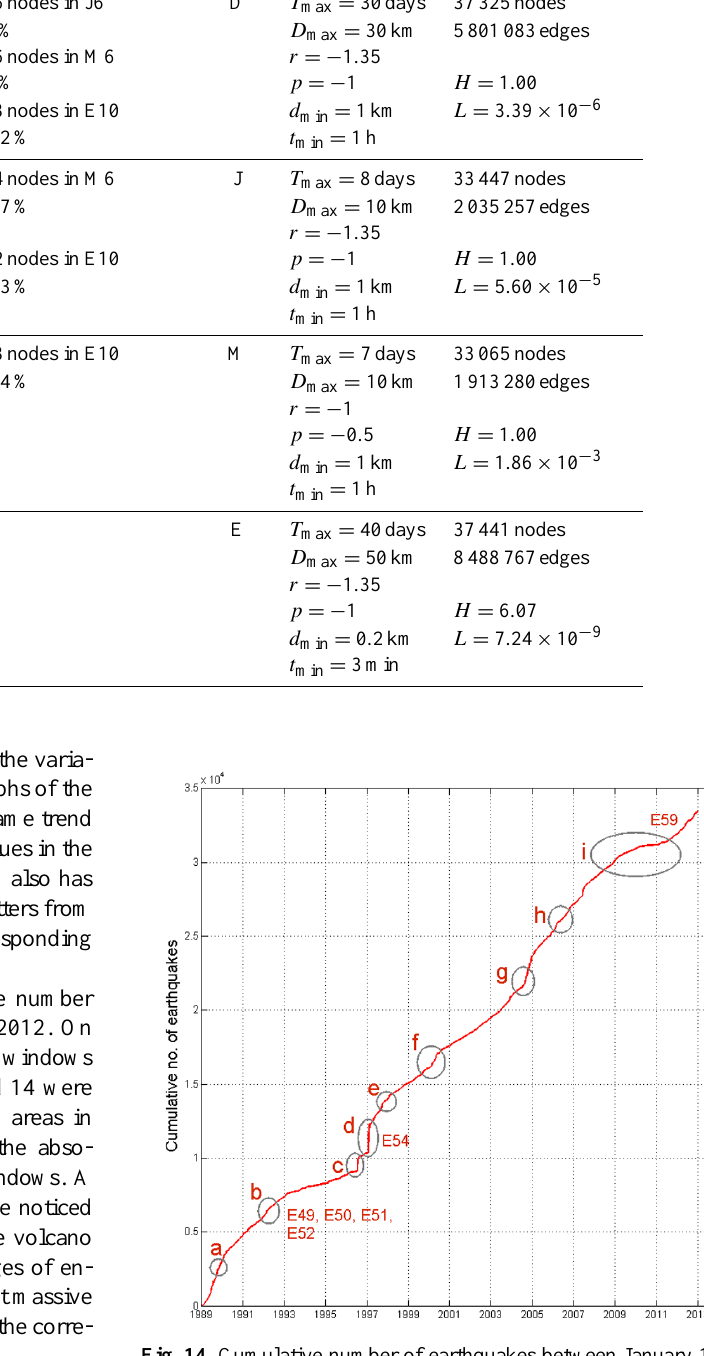
Fig. 14. Cumulative number of earthquakes between January 1989 and December 2012. The small letters tag the areas corresponding to the minimum absolute values of the exponents β and γ in successive temporal windows of network